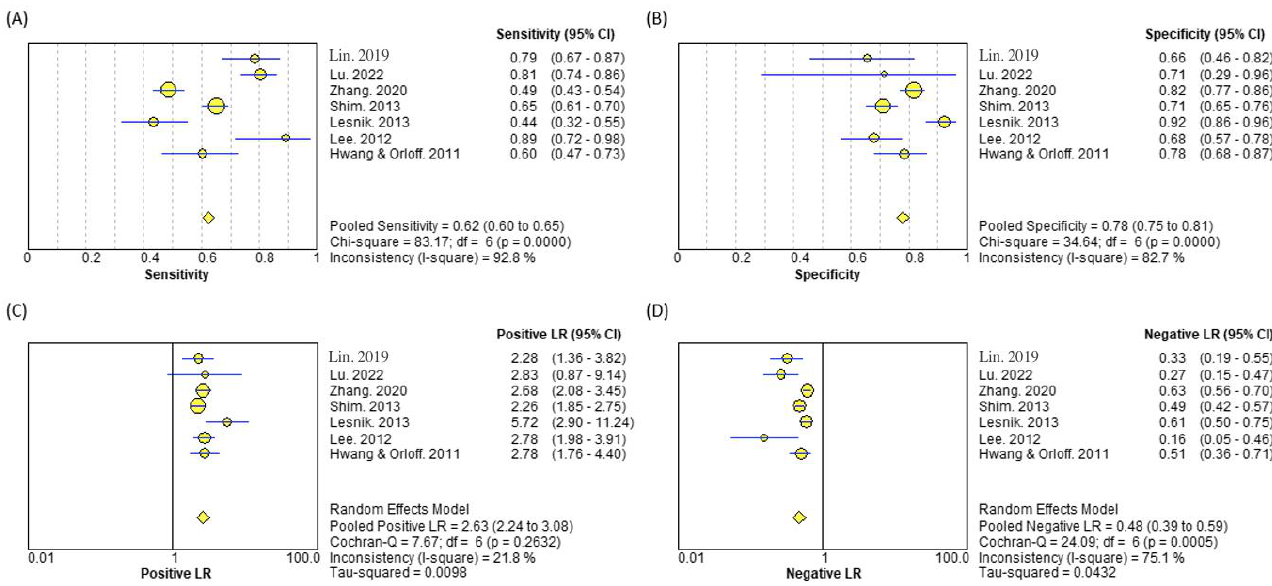
Figure 3. Diagnostic parameters of ultrasound performed by non-radiologists [13,19,21,22,31,33,41]. The ( A ) sensitivity, ( B ) specificity, ( C ) positive likelihood ratio, and ( D ) negative likelihood ratio are presented. Data is reported as an estimate and 95% confidence interval. Heterogeneity was assessed using Cochran-Q test and magnitude was estimated by the I-square value. CI = Confidence Interval; LR = Likelihood Ratio.